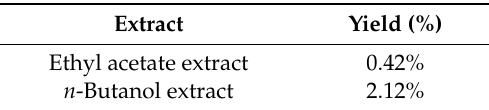
Table 1. Extractive values of Euphorbia dendroides